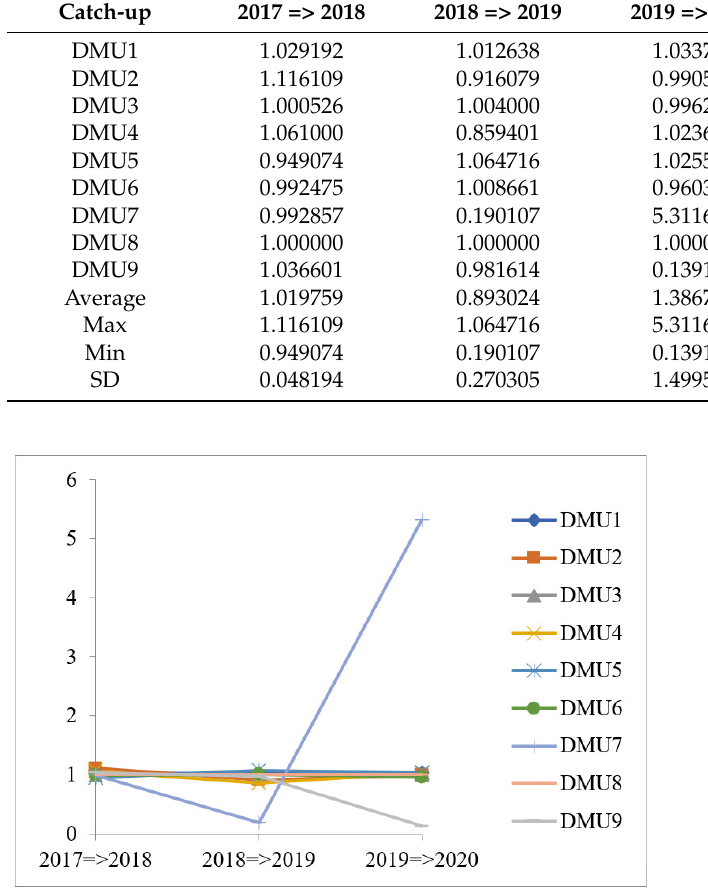
DMU5 and 7 scores revealed an improvement in the last span compared with the first